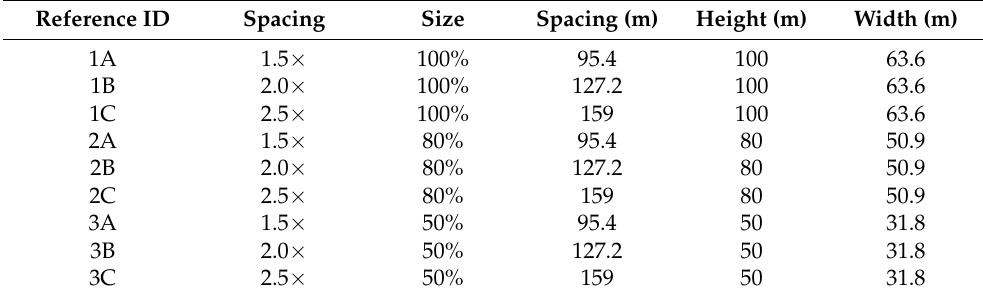
Table 1. Details of neighboring structures in nine urban scenarios for Skyscraper Farm in a City